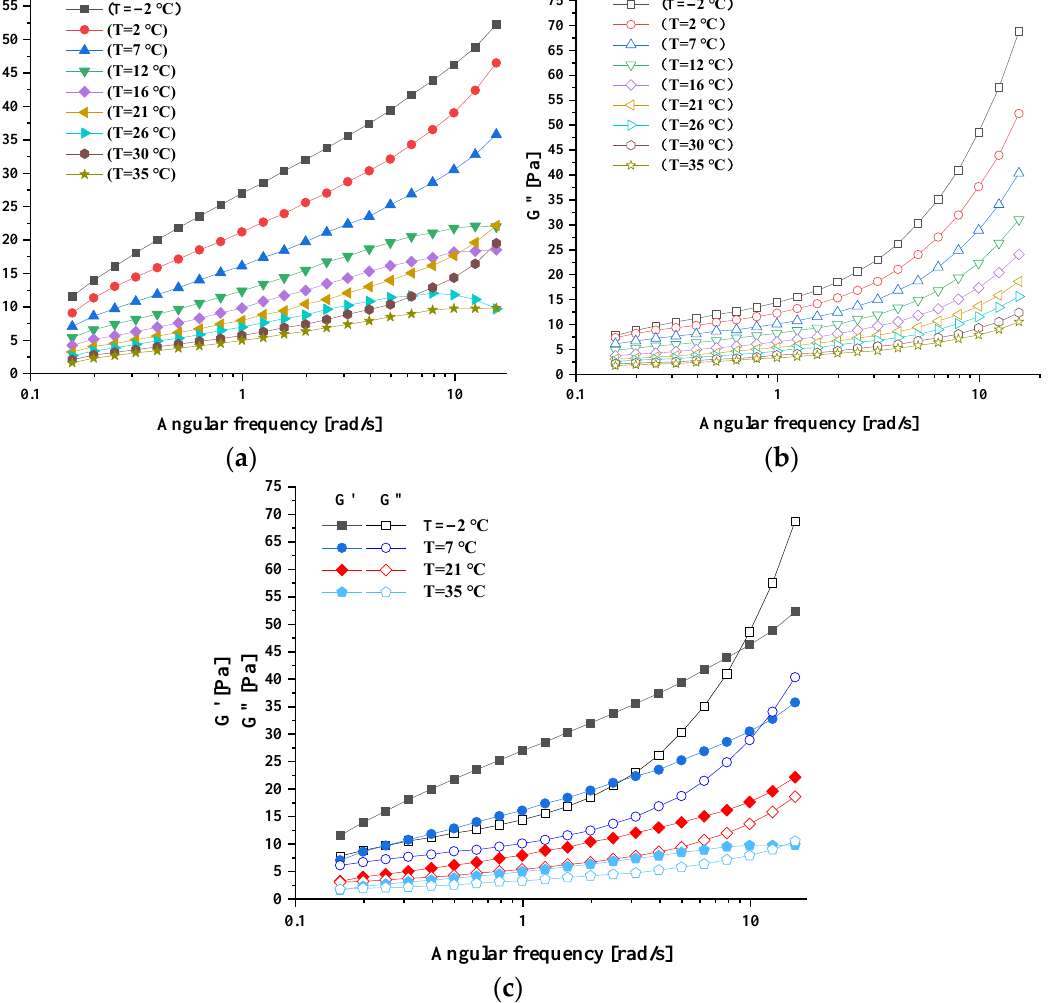
Figure 7. Frequency scanning modulus curve of FF at different temperatures: ( a ) storage modulus curve; ( b ) loss modulus curve; ( c ) comparison of the intersection points of the two